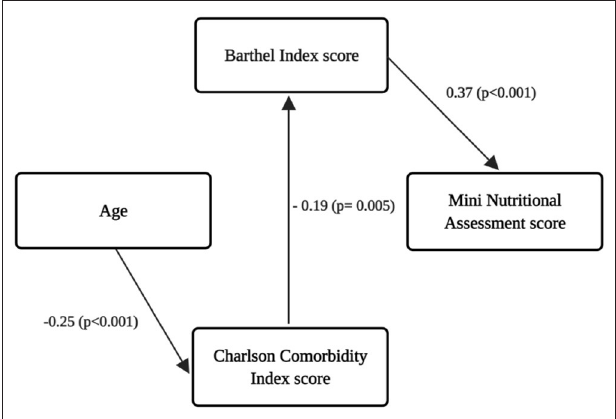
FIGURE 2 | Adjusted model showing the significant associations among